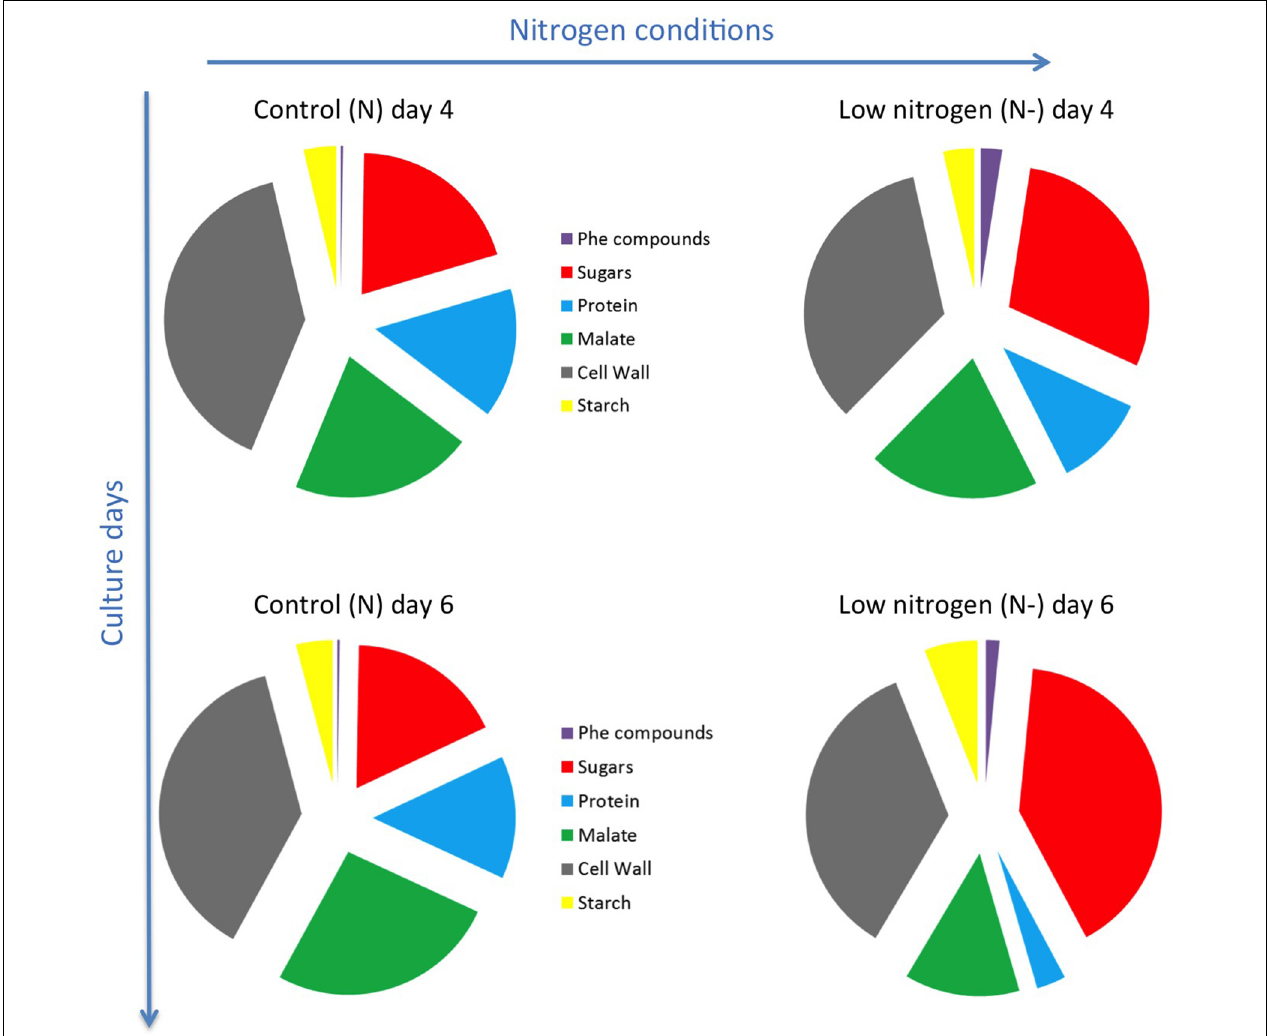
FIGURE 3 | Schematic representation of biomass balance of GT3 cells at day 4 and 6 of culture. Phe: Phenolic; control conditions (N, 25 mM KNO 3 ); low nitrogen (N–, 5 mM KNO 3